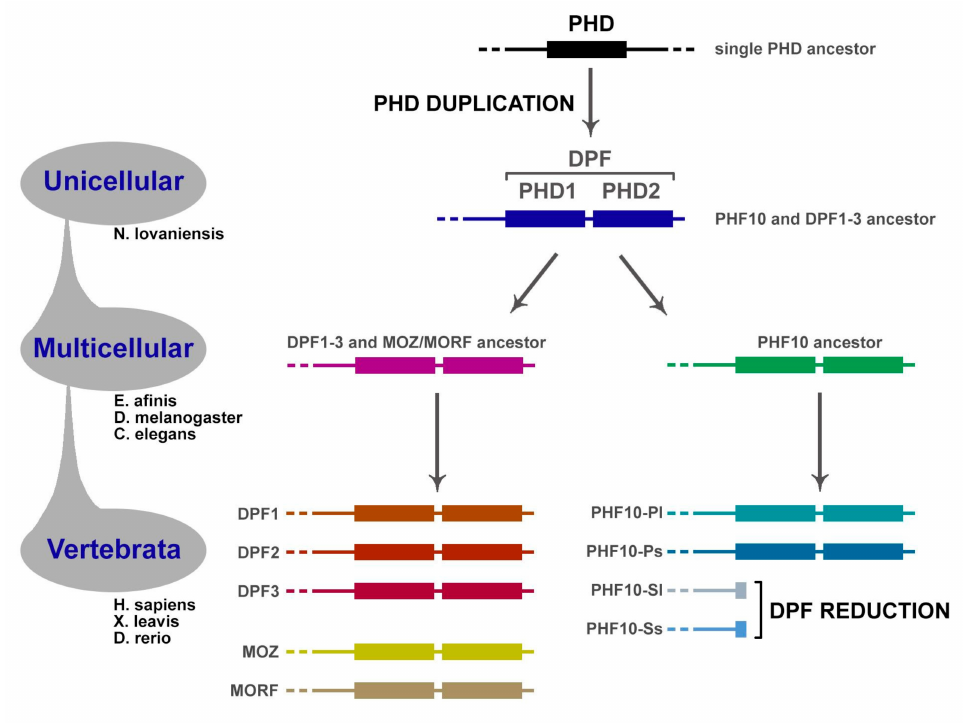
Figure 5. Evolution of DPF-containing proteins. Originally, PHF10 and the gene ancestral to DPF1 – 3 and MOZ / MORF groups diverged from the common ancestor. Afterwards, the latter group multiplied to five members. Most likely, PHD duplication occurred in the very last eukaryotic common ancestor, since the DPF domain is present in all these